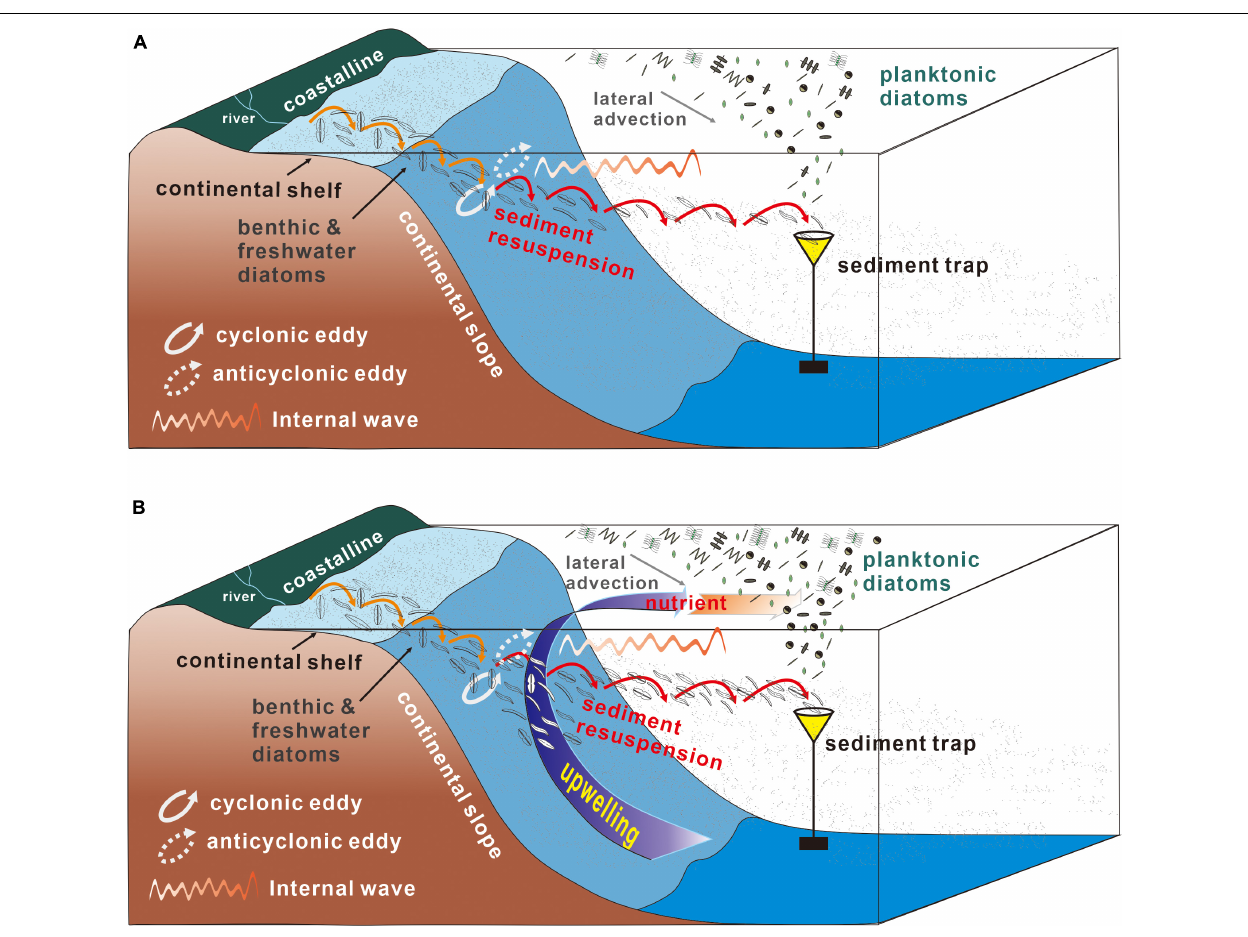
FIGURE 9 | Schematic diagrams of the sources and transport of resuspended sediment from the continental slope to the deep water in the northwestern SCS: (A) general case and (B) enhanced sediment resuspension by coastal